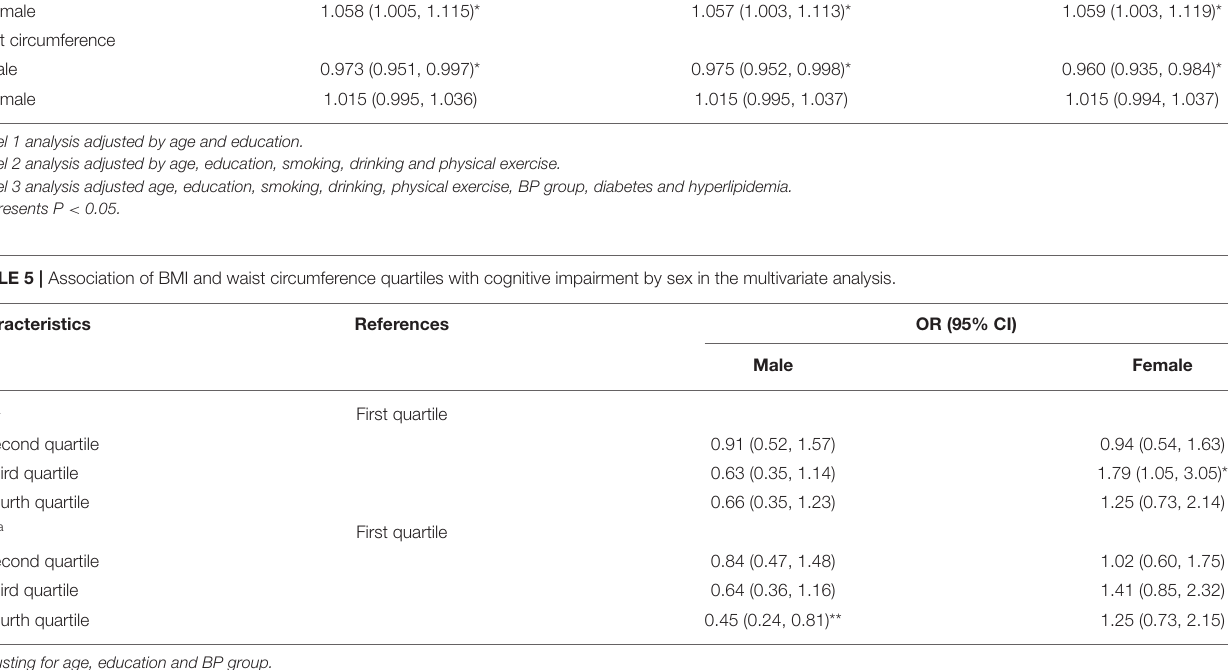
Waist circumference Male 0.973 (0.951, 0.997)* 0.975 (0.952, 0.998)* 1.015 (0.995, 1.036)